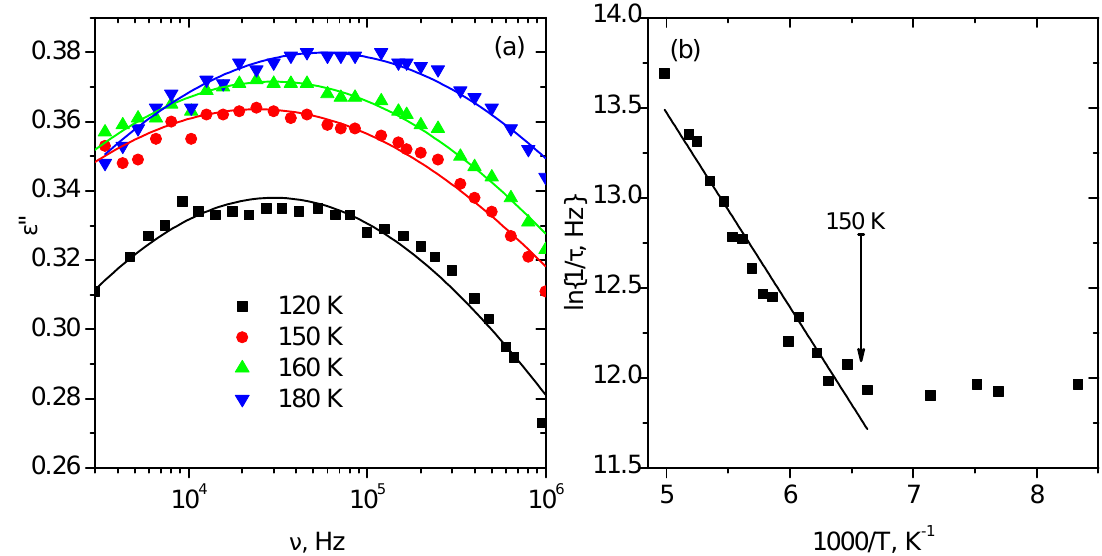
Figure 5. Frequency spectra of composite with 11 vol % of Ni@C ( a ). Temperature dependence of relaxation time for composites with 11 vol % of Ni@C ( b